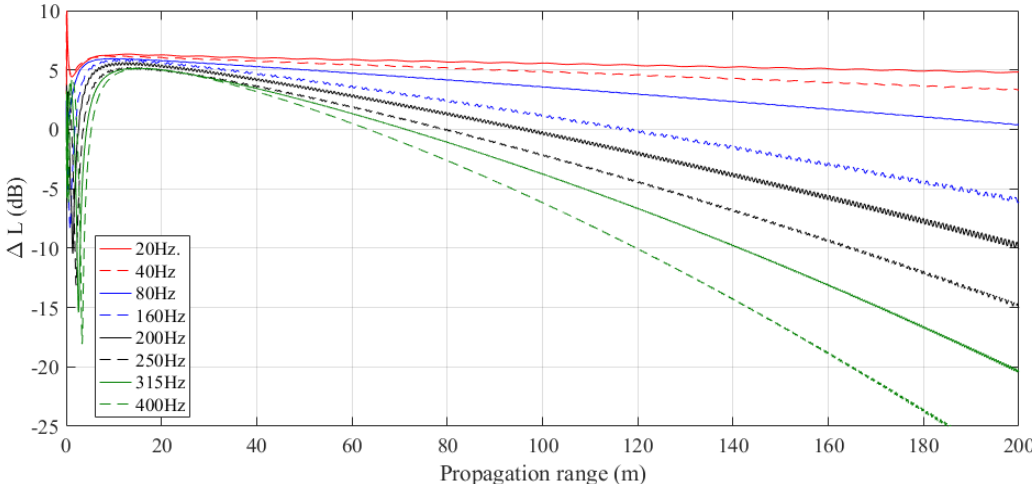
Figure 7. Sound transmission loss over 200 m at various frequencies (rigid ground and upward refraction).